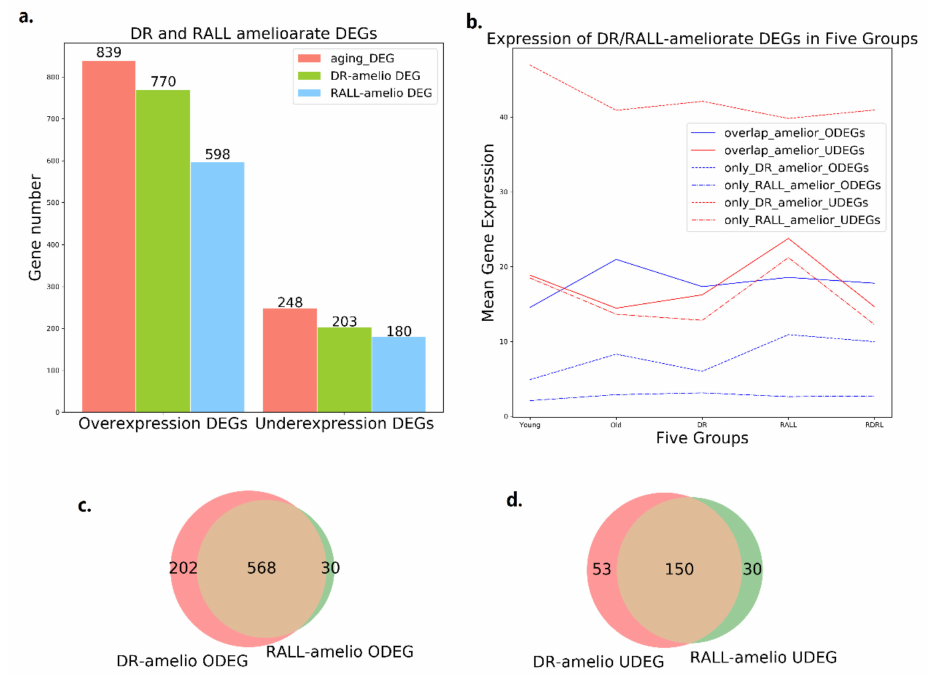
Figure 2. Different expression genes and DR/RALL-ameliorated genes: ( a ) number of aging-related DEGs, DR-ameliorated DEGs and RALL-ameliorated DEGs, groups distinguished by overexpression or underexpression; ( b ) mean expression of DR/RALL-ameliorated DEGs in five mice groups; ( c ) number of overlapping genes between DR-ameliorated and RALL-ameliorated ODEGs; and ( d ) number of overlapping genes between DR-ameliorated and RALL-ameliorated